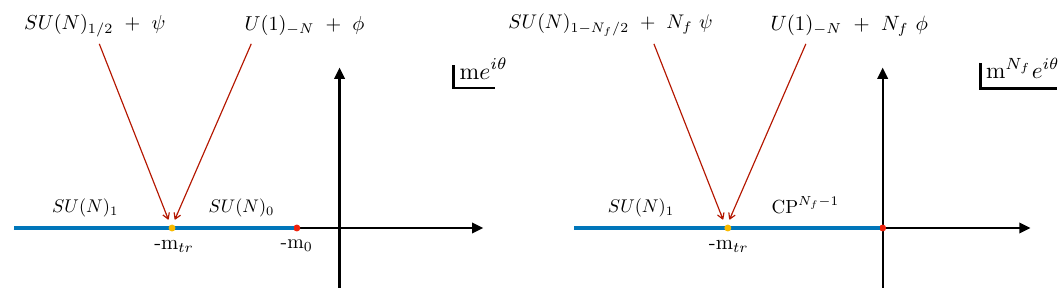
Figure 1 . Domain walls of massive QCD at (cid:18) = (cid:25) and their phases in the complex m N f e i(cid:18) plane, including the proposed three-dimensional CS theories describing them. On the left, QCD with N f = 1; on the right, QCD with 1 < N f < N CFT . The blue line represents the values of quark masses for which the domain wall exists. At m tr (cid:24) (cid:3) a phase transition occurs. The DW ceases to exist at m = m 0 and m = 0 for N f = 1 and N f > 1,